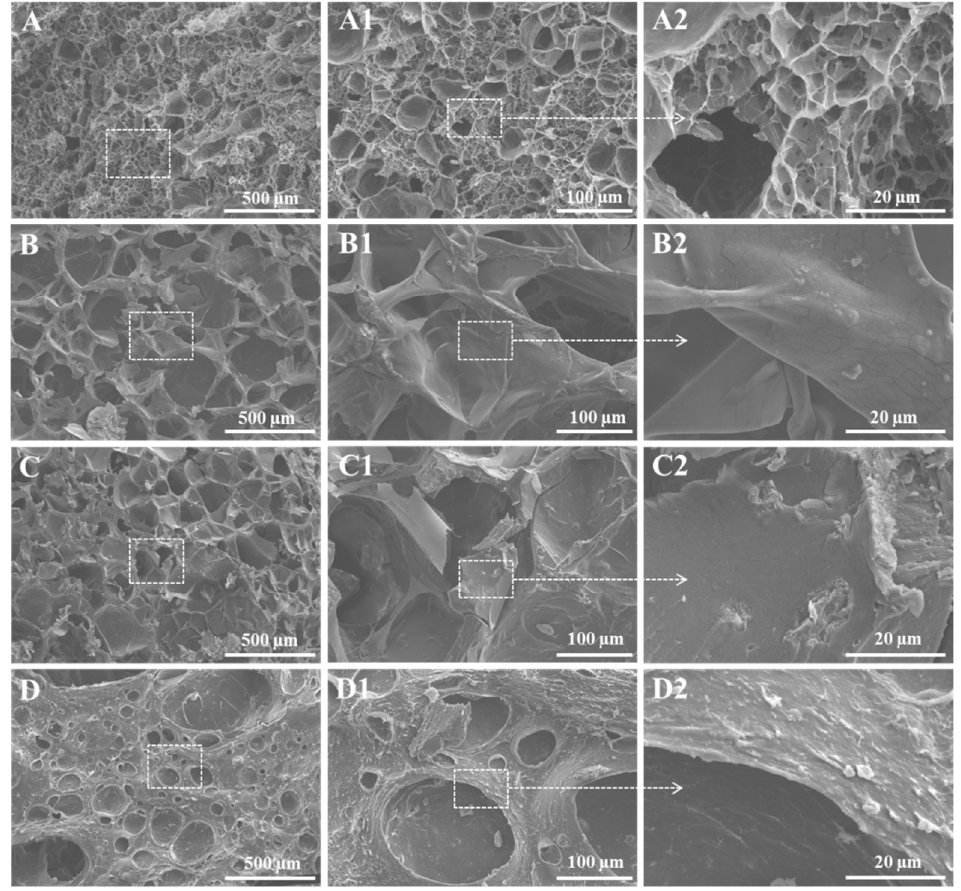
Figure 3. SEM image of crosslinked and nanofiller-reinforced hybrid hydrogels: S1 ( A – A2 ), S2 ( B – B2 ), S3 ( C – C2 ), and S4 ( D – D2 ), respectively.